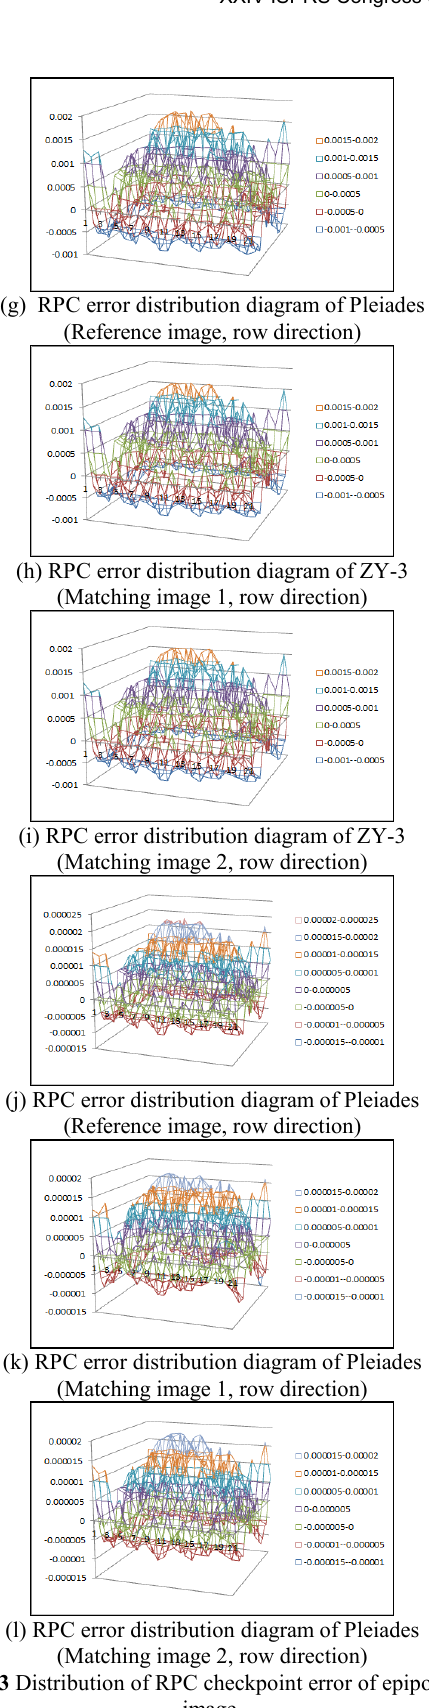
Figure 3 Distribution of RPC checkpoint error of epipolar line image.